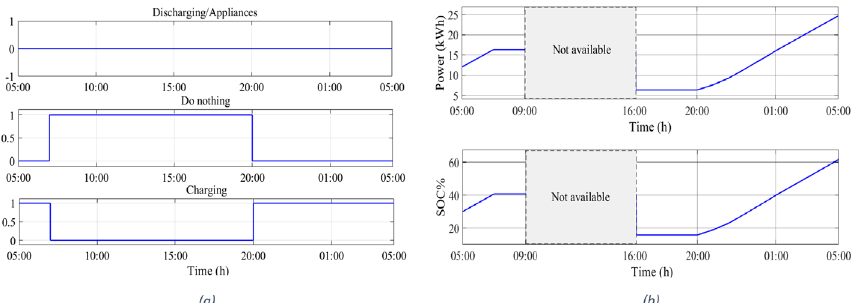
Fig. 16 a PEV management fuzzy controller output, b PEV power and